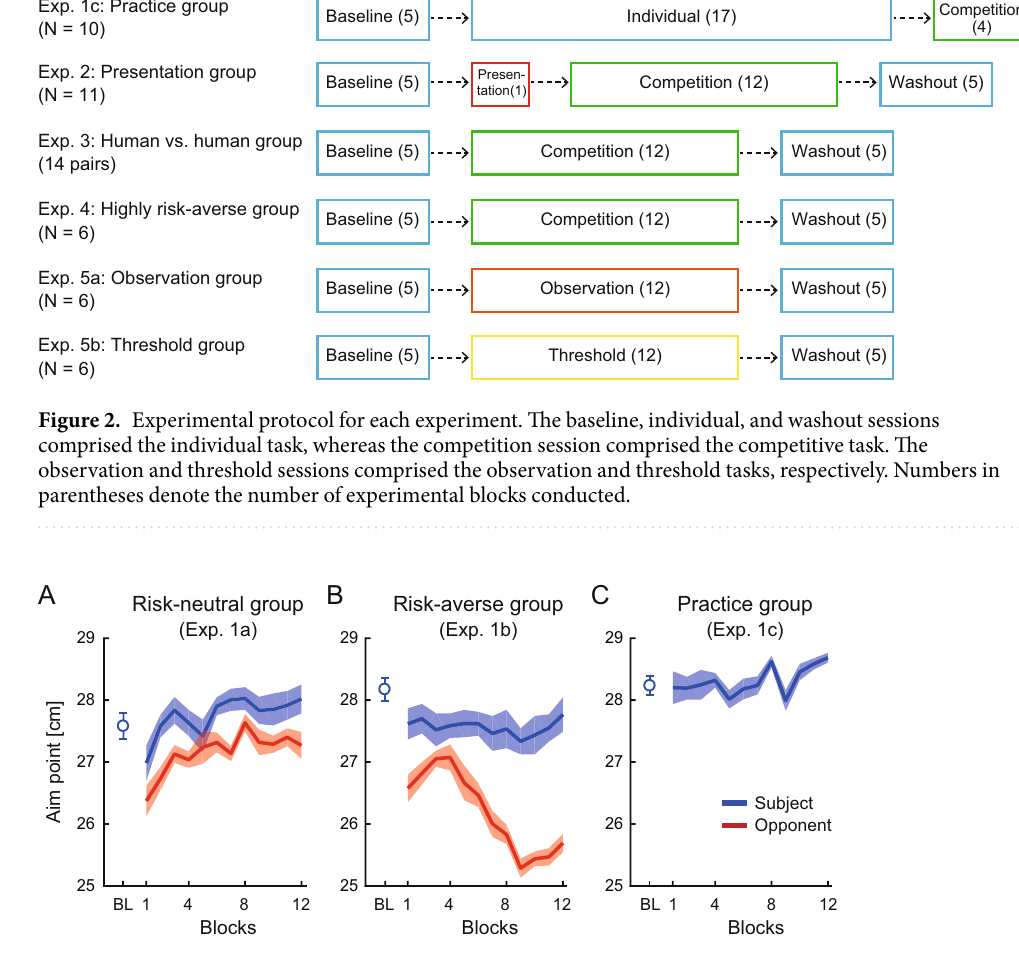
Figure 3. Effect of opponent’s aim points on subject’s aim points. ( A–C ) Change of aim point (mean endpoint) when competing against a ( A ) risk-neutral opponent, ( B ) risk-averse opponent, and ( C ) performing the individual task. Data is averaged across the subjects, and the shaded area denotes the standard error of the mean. In the risk-neutral group, the subjects’ aim points increased as the opponents’ aim points increased. In contrast, the subjects’ aim points in the risk-averse group did not change, whereas the opponent’s aim points